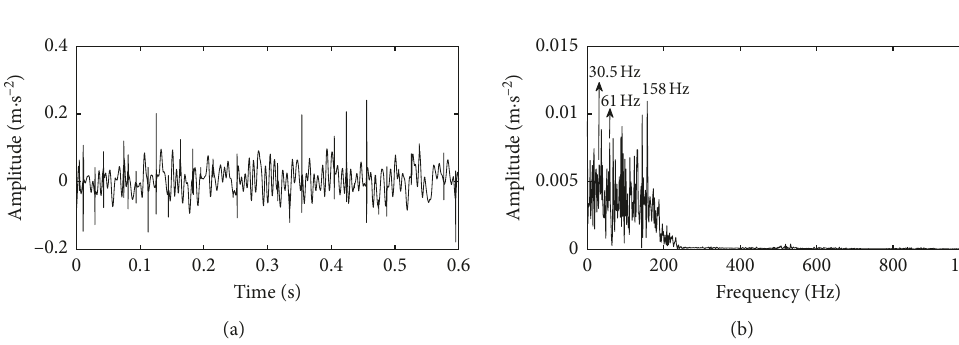
Figure 8: Results of wavelet thresholding. (a) Waveform in the time domain. (b) Frequency